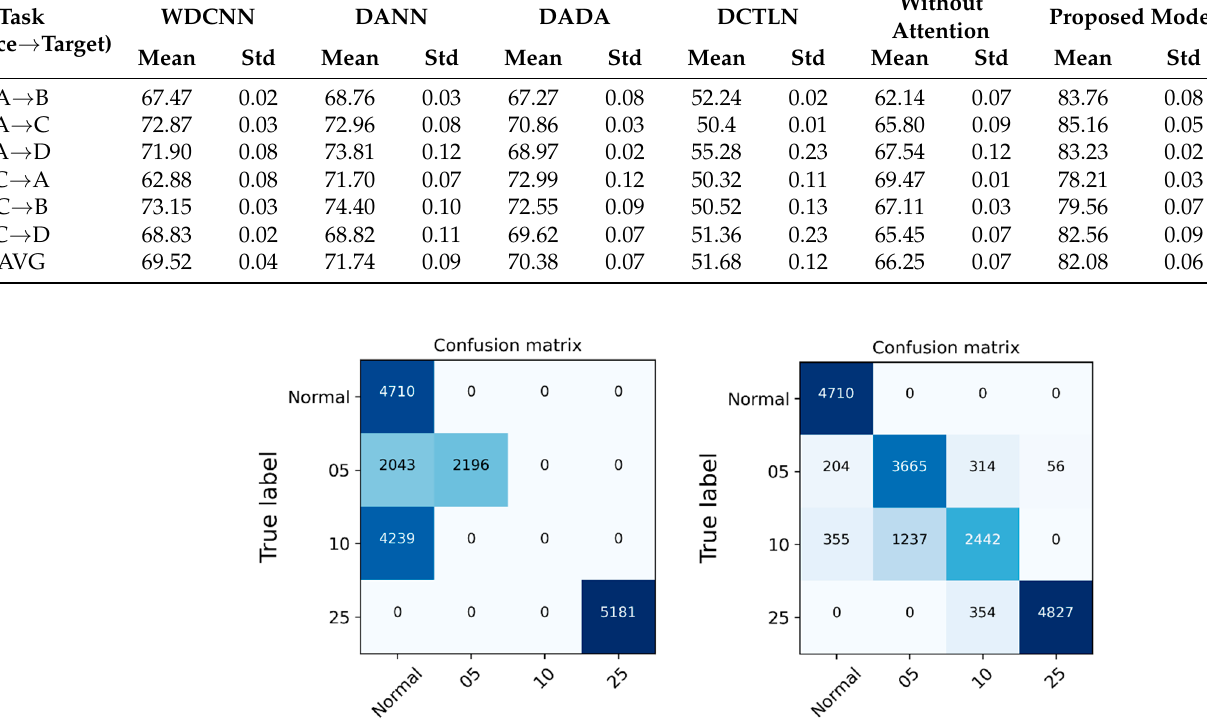
Table 8. The comparison accuracy of classification results on the real machine dataset.